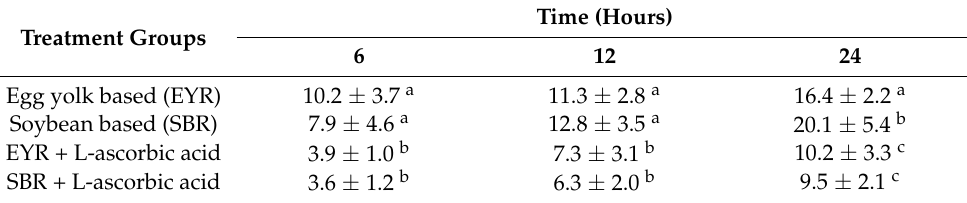
Table 6. Morphological defects (%) of turkey spermatozoa over 24 h at 4 ◦ C. Treatment